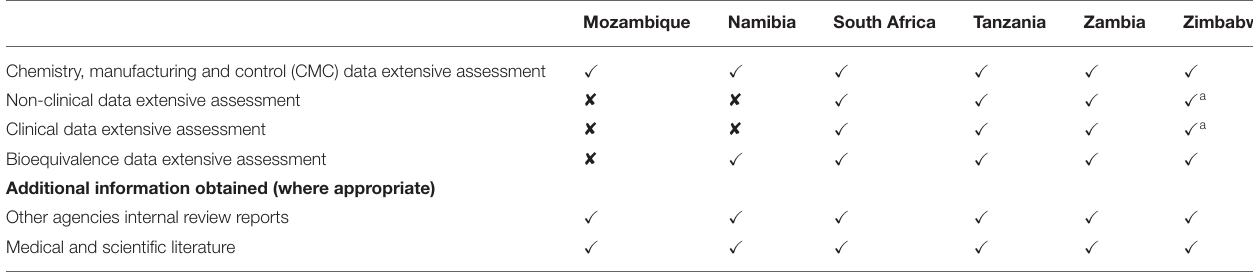
TABLE 4 | Extent of scientific assessment for full review.